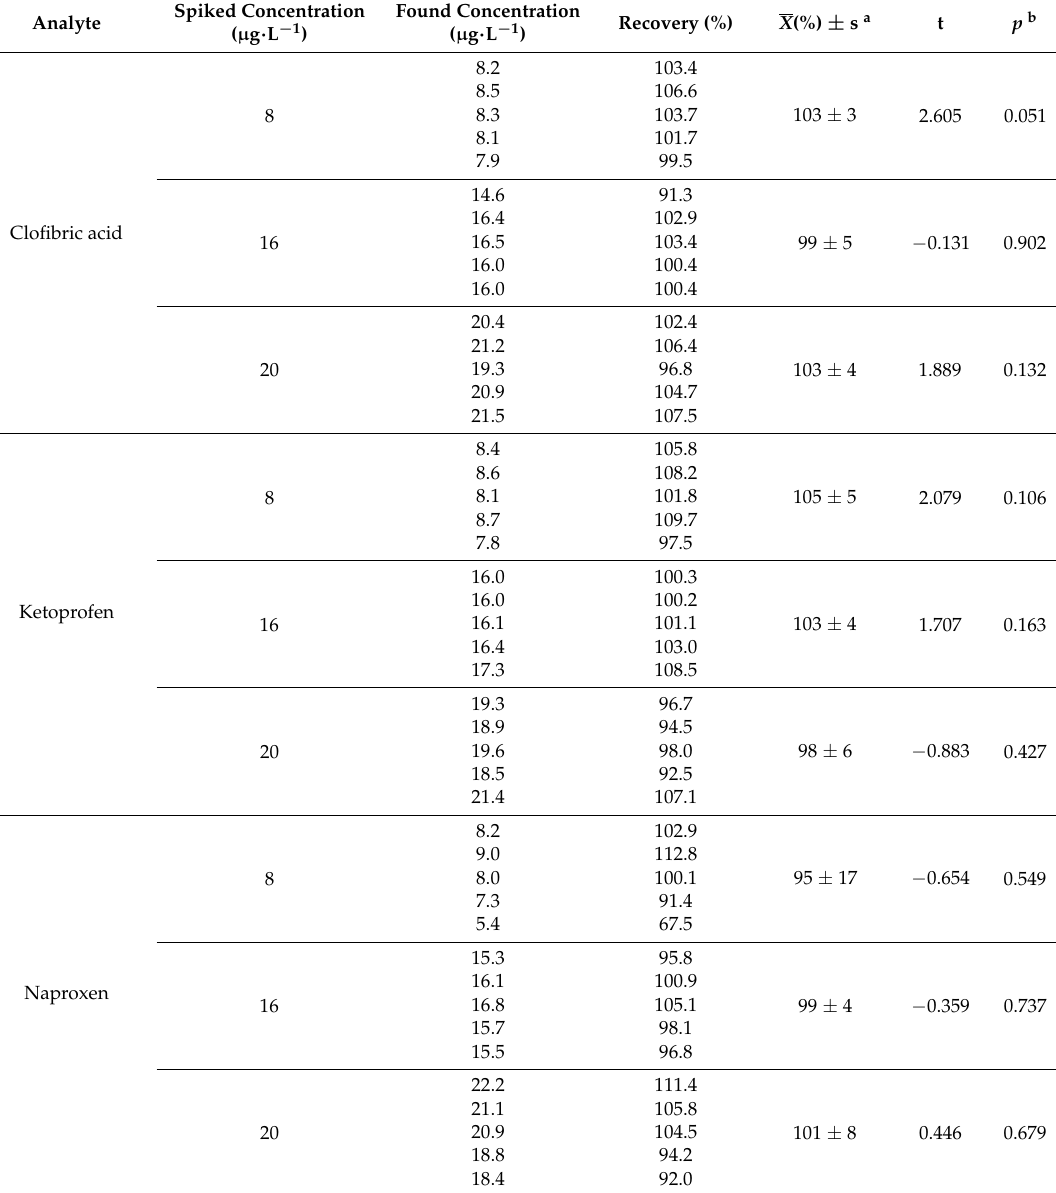
Table 6. Recovery study results in Genil River water